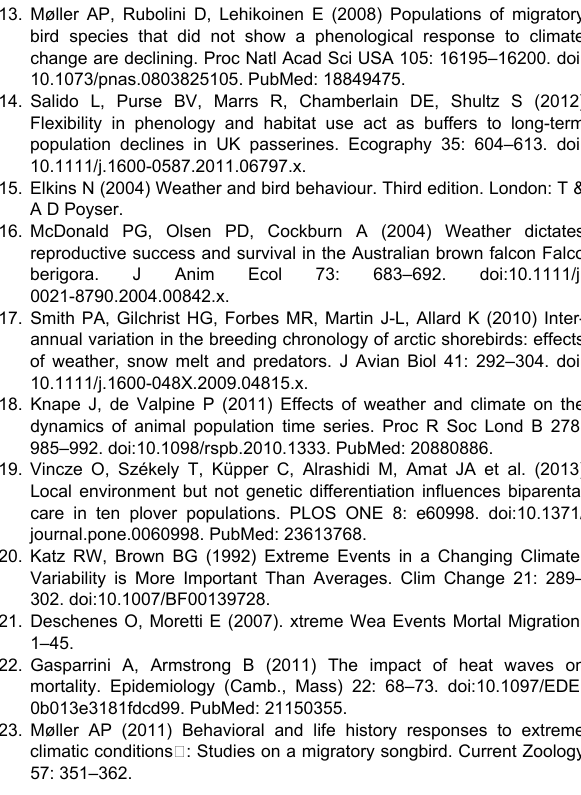
Table S6. Model set for sex ratio at fledging; models with ∆AIC>2 are written in bold (n=61